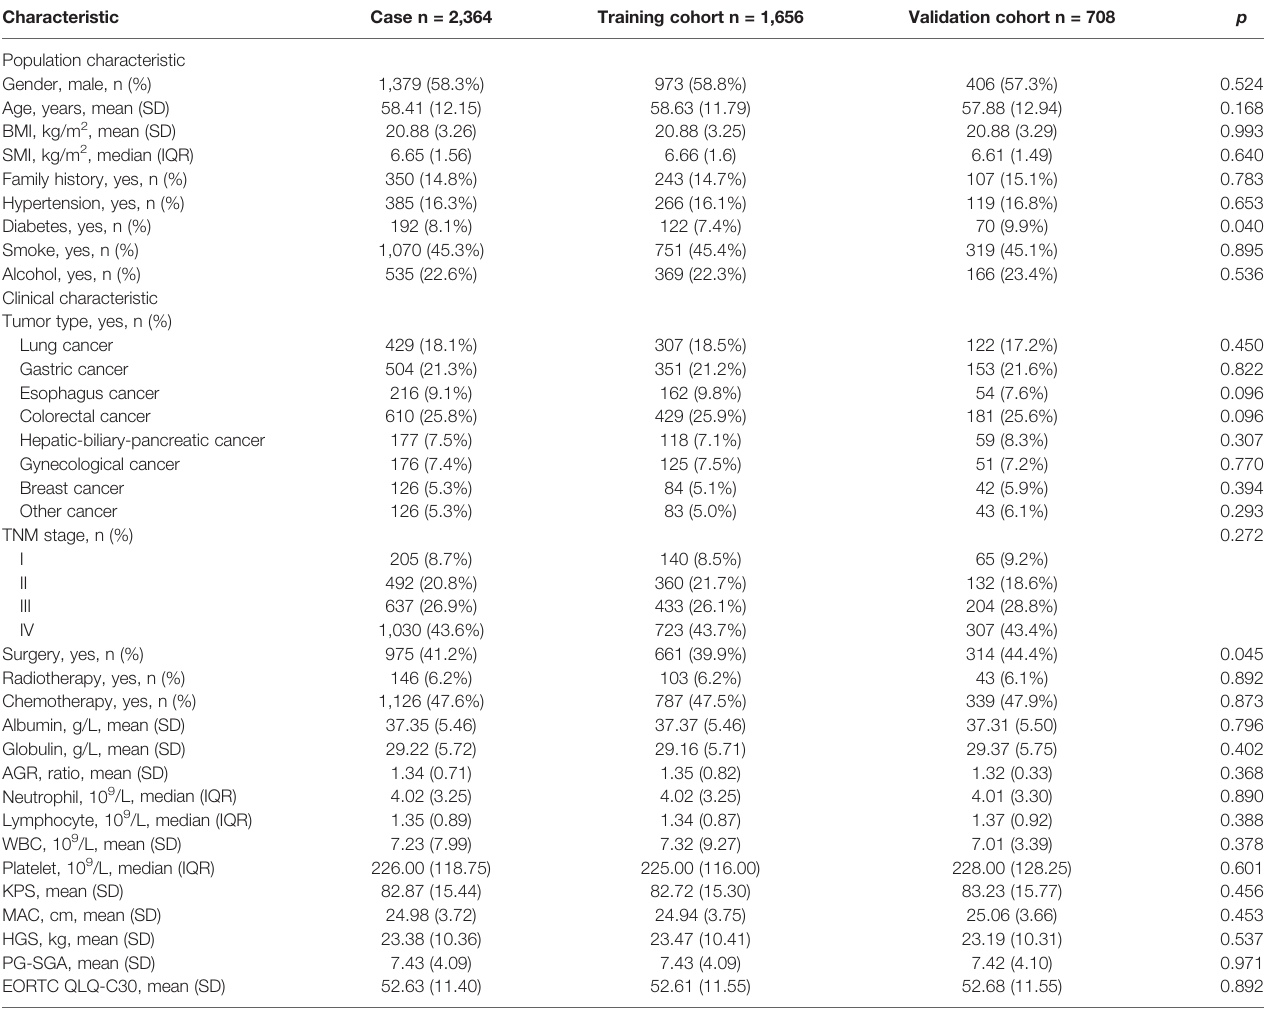
TABLE 1 | Demographics and clinicopathological characteristics of cachexia patients. Characteristic